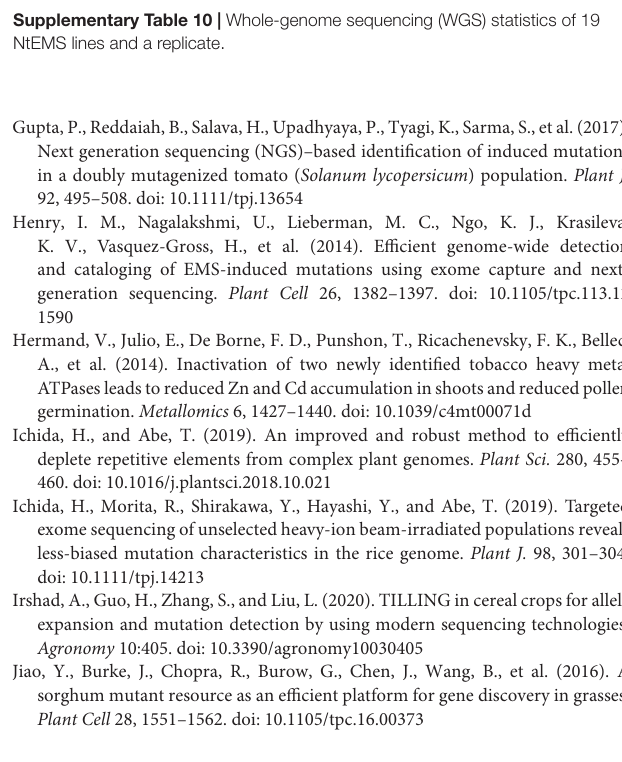
mutagenesis (right axis) was also shown based on the probability formula by Clarke and Carbon (1976). Supplementary Figure 4 | Stacked bar chart of mutations detected in the target and the flanking regions with different numbers of sequencing reads. The data are the total number of mutations detected in the 19 NtEMS lines with different numbers of sequencing reads: all clean sequencing reads (“all”) and down-sampled sequencing reads (160 × , 140 × , 120 × , 100 × , 80 × , 60 × , 50 × , 40 × , 30 × , 20 × , and 10 × total CDS length equivalent) by whole-exome sequencing. More mutations were detected in the target regions than in the flanking regions 1–25 to 176–200 distant from the target regions. Supplementary Table 1 | Positions of additional genes that are defined in the genome of tobacco cultivar TN90 but not in K326 (Sierro et al., 2014). Supplementary Table 2 | Positions of unannotated putative homeologs of gene_85817 and gene_74284 in the genome of tobacco cultivar TN90 (Sierro et al., 2014).